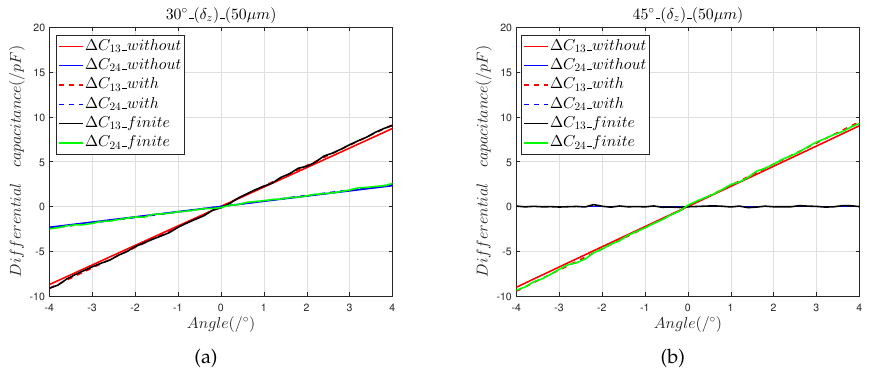
Figure 7. The 50 µ m radial installation error analysis: ( a ) differential capacitance in the 30° direction; ( b ) output capacitance in the 45°